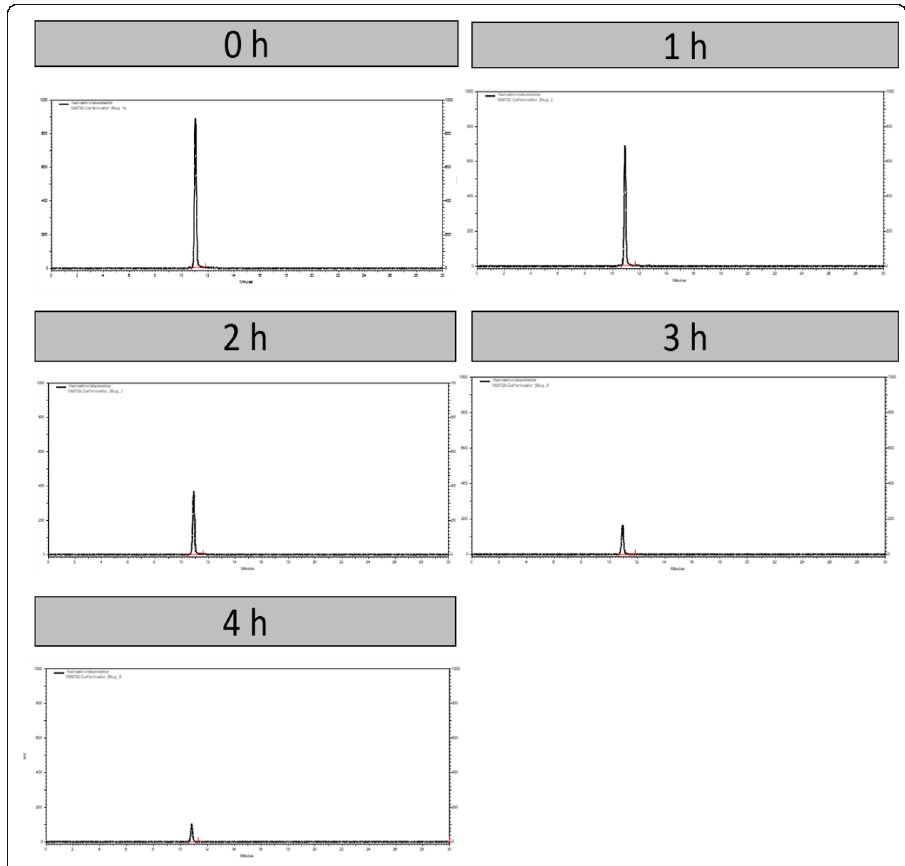
Fig. 5 Stability of 50 μ g [ 68